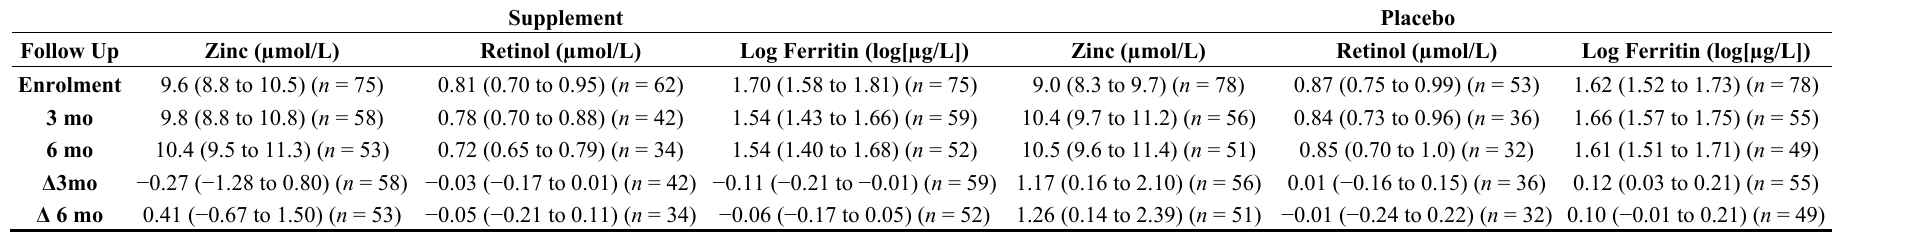
Table 3. Micronutrient status of the children during intervention period.